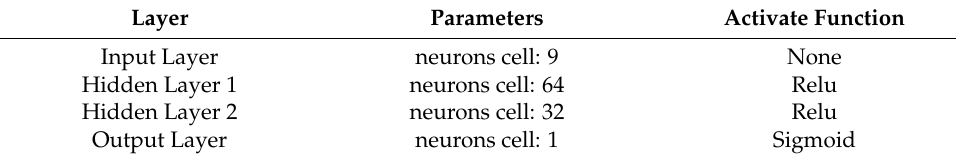
Table 2. Parameters of the PPM